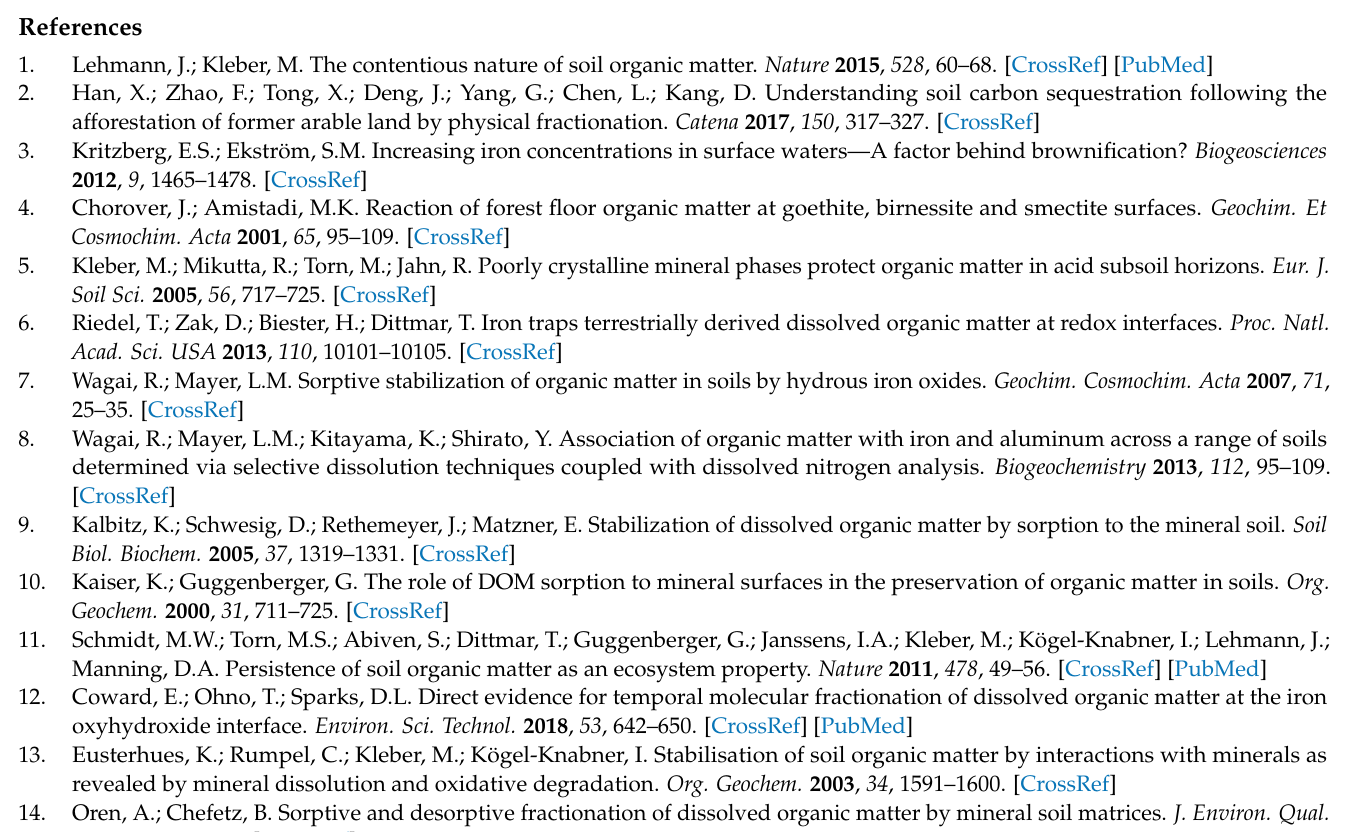
Table S1: The soil properties of in hardwood forest, cropland with manure application, and continu- ous pasture soils at 0–10 cm and 10–25 cm depth; Table S2. The estimated linear regression using the standard square least approach between total organic carbon, Fe-bound OC and reactive Fe and the combined silt and clay content in in hardwood forest, cropland with manure application, and continuous pasture soils at 0–10 cm and 10–25 cm depth; Table S3. The adsorption character- istics of three land type soils at 0–10 cm and 10–25 cm depths. References [87–95] are cited in the supplementary